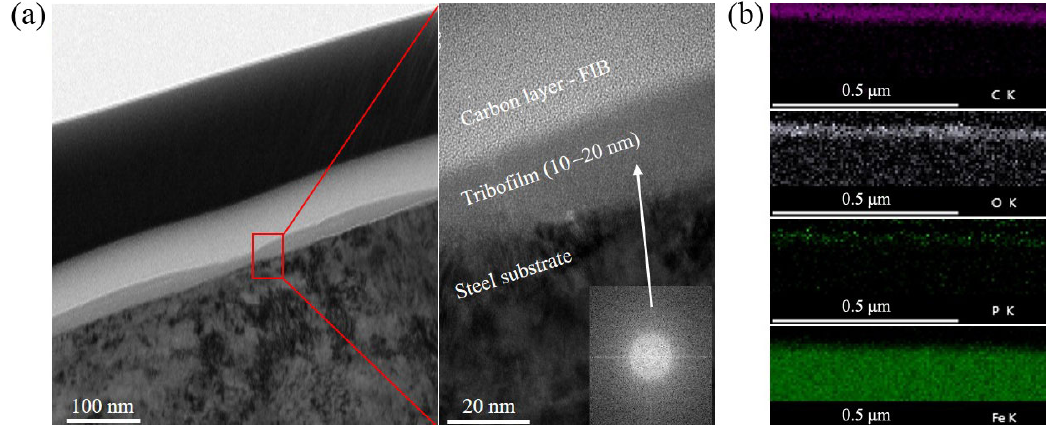
Fig. 11 (a) TEM micrographs and electron diffraction pattern (bottom right) and (b) EDS elemental mappings of the tribofilm on the SRV disc surface lubricated with ILb2 at 90